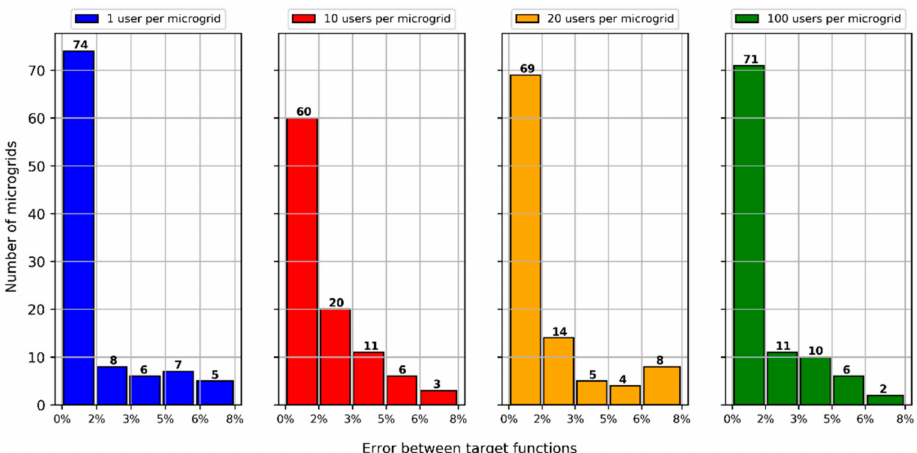
Figure 15. Percentage difference between cost functions of the deterministic and stochastic problems, by groups of microgrids (Case